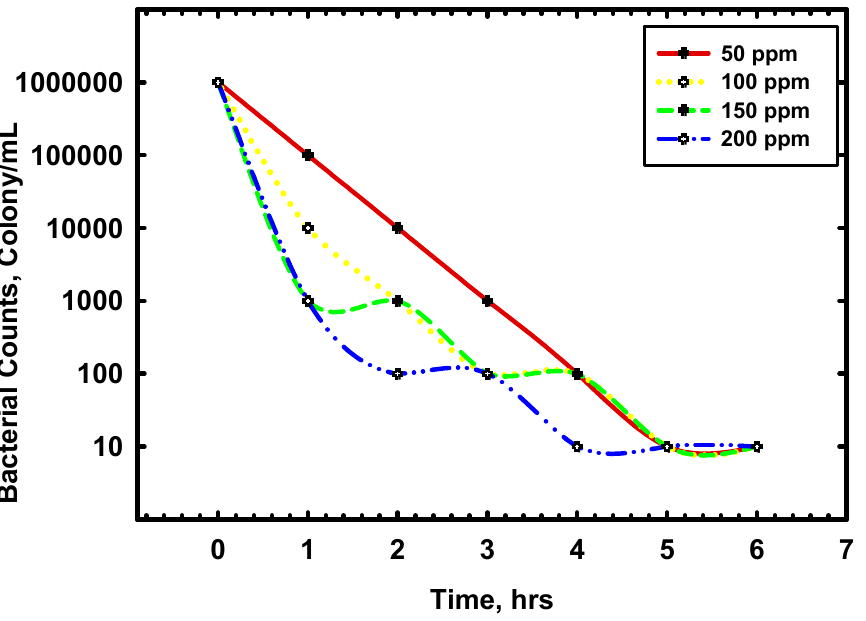
Figure 4. The decay of bacterial counts with time at different concentrations of the ionic liquid